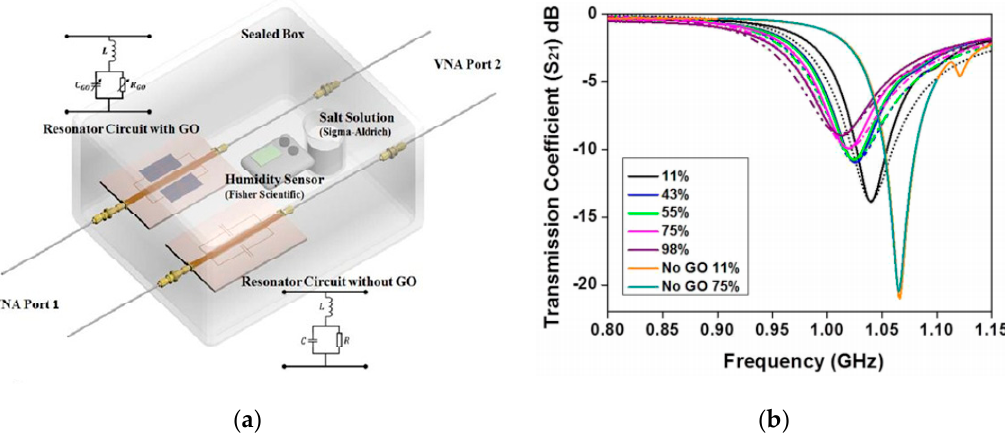
Figure 10. Graphene oxide-based humidity sensor. ( a ) Resonator circuits for permittivity measurement of GO and ( b ) behavior of measured (solid lines) and simulated (dashed lines) S 21 − resonance of the sensors with/without GO layer as RH concentrations increase [84].